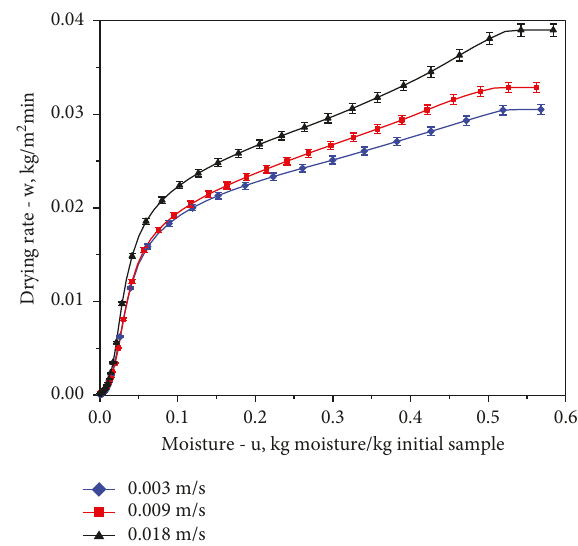
Figure 6: Influence of furnace air velocity on drying rate for 2.4 mm thick layer of spent coffee